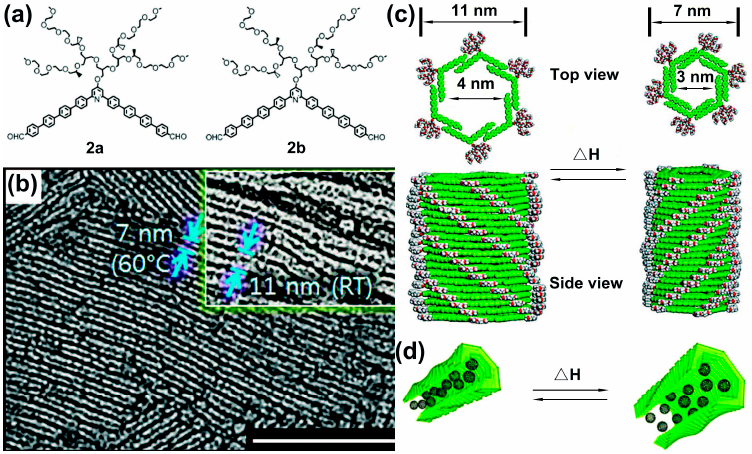
Figure 6. ( a ) Molecular structures of enantiomeric bent-shaped amphiphiles 2a (left) and 2b (right); ( b ) TEM images of 2a tubules (0.01 wt % aqueous solution) prepared at 60 °C or room temperature (inset), scale bar: 100 nm; ( c ) Schematic illustration of pulsating rotation of the nanotubules accompanied by a chiral inversion, triggered by using thermal stimuli; ( d ) Schematic illustration of thermo-modulated packing variations of encapsulated C 60 molecules. Reproduced from [25] with copyright permission.